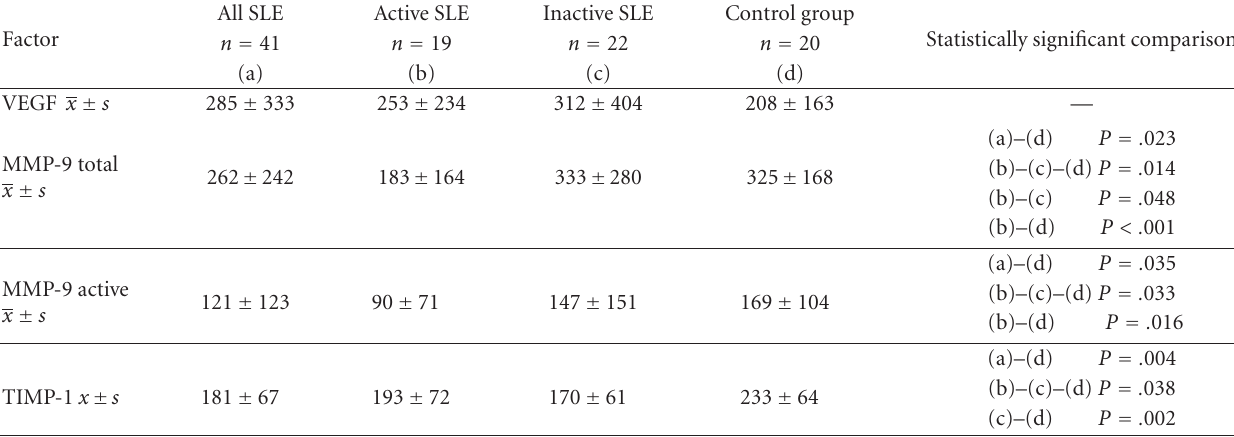
Table 2: Serum levels of VEGF, total and active metalloproteinase-9 (MMP-9), and TIMP-1 in patients with SLE and control group (mean values of VEGF in pg/mL, metalloproteinase-9, and TIMP-1 in